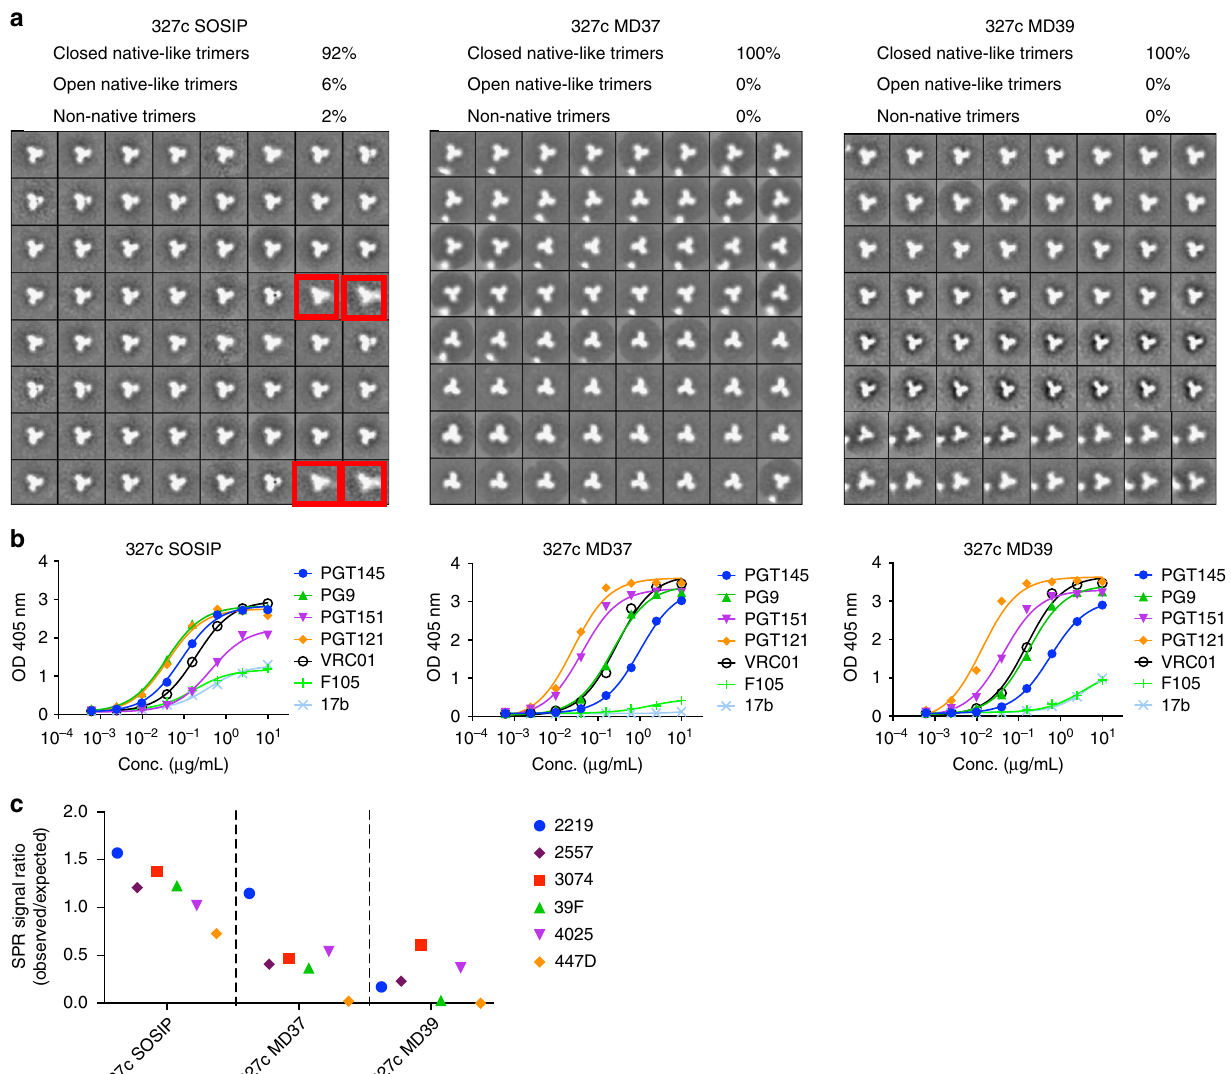
Fig. 6 Structural and antigenic assessment of 327c trimer with different stabilization designs. a 2D class averages from negative-stain EM analysis of 327c SOSIP, 327c MD37 and 327c MD39 trimers, which are classi fi ed as closed-native-like, open native-like or non-native. Red boxes indicate examples of open native-like trimers. b ELISA-binding curves for bnAbs and non-nAbs against 327c SOSIP, 327c MD37 and 327c MD39 trimers c SPR signal ratio for the V3 non-nAbs binding to 327c SOSIP, 327c MD37 and 327c MD39 trimers. The data are from one experiment and measurements are done in